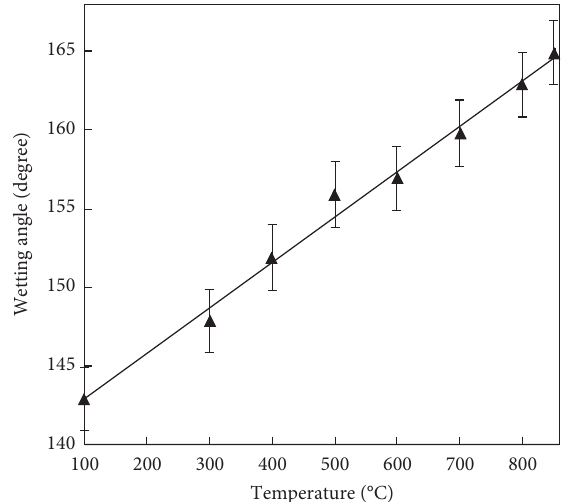
Figure 11: Variation of contact angle (measured in the gas phase) as a function of temperature on Si